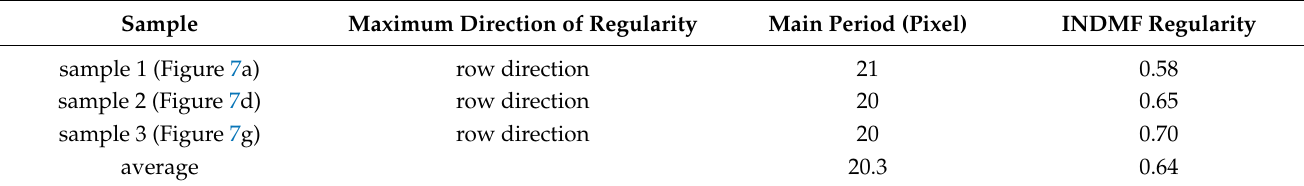
Figure 7. INDMF regularity based on loess ridge areas. ( a ) sample 1; ( b ) positive and negative terrains of sample 1; ( c ) INDMF of sample 1; ( d ) sample 2; ( e ) positive and negative terrains of sample 2; ( f ) INDMF of sample 2; ( g ) sample 3; ( h ) positive and negative terrains of sample 3; ( i ) INDMF of Table 8. Results of main period and INDMF regularity in the loess ridge areas.